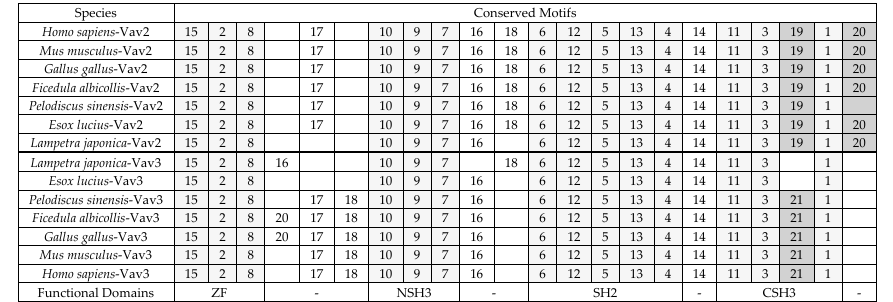
Figure 3. The distribution pattern of conserved motifs between Vav2 and Vav3 molecules. The conserved motifs (recurring, fixed-length patterns) were discovered with the online tool Multiple Em for Motif Elicitation (MEME) as described in Materials and Methods. The number and the widths of conserved motifs were set as 25 and 5–20 amino acids, respectively. The abbreviations of protein functional domains are the same as described in Figure 1. Light gray columns show the conserved motifs between Vav2 and Vav3 groups and dark gray columns mark the diversified motifs between Vav2 and Vav3 group. The protein accession numbers are included in Figures 1 and 2.